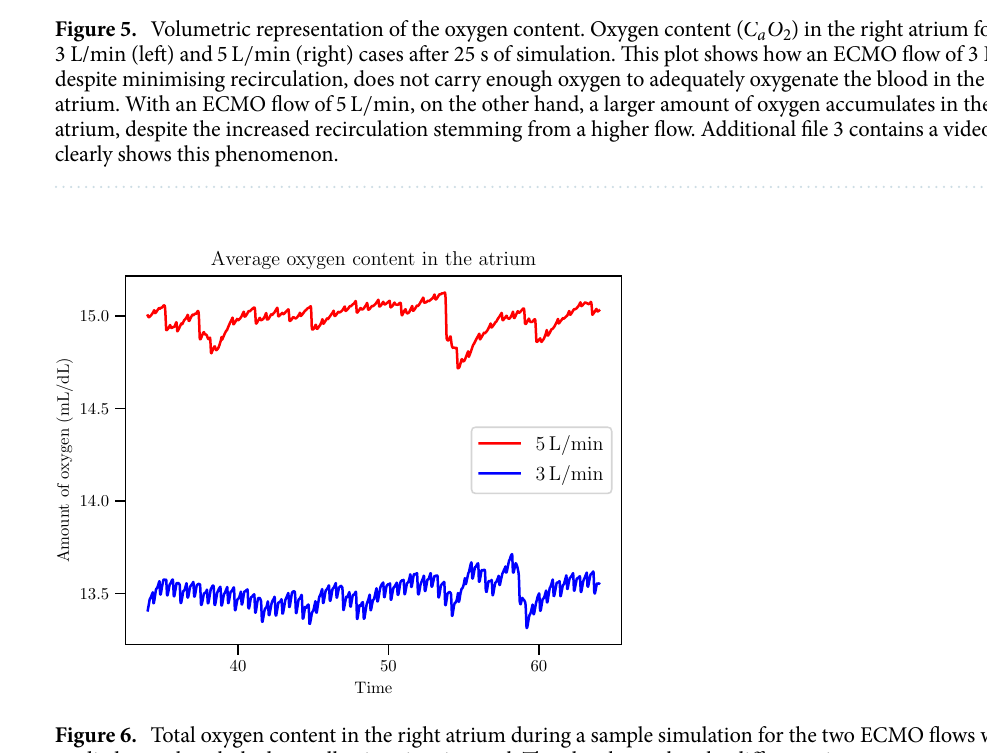
ECMO flow versus cannula positioning. The ECMO flow is more important than the fine tuning of the cannula positions. The saturation charts in Fig. 2 highlight the minimal impact of the cannula positions on the VV-ECMO outcome. In each of them, the values are pretty similar and there is not much difference between the best and the worst configuration. Figure 2a shows that the best configurations for an ECMO flow of 3 L/min are the ones with the returning cannula closest to the right atrium. One possible explanation is that, since the incoming oxygenated blood is slower, less of it flows into the inferior vena cava and more of it remains into the right atrium. This affects positively the effectiveness of the procedure. Nevertheless, the difference between the best and the worst cases is very small. Figure 2b has a different gist: the best configurations for an ECMO flow of 5 L / min are not necessarily the ones with the returning cannula at its closest and there seems to be no clear pattern. In this case, the blood flow